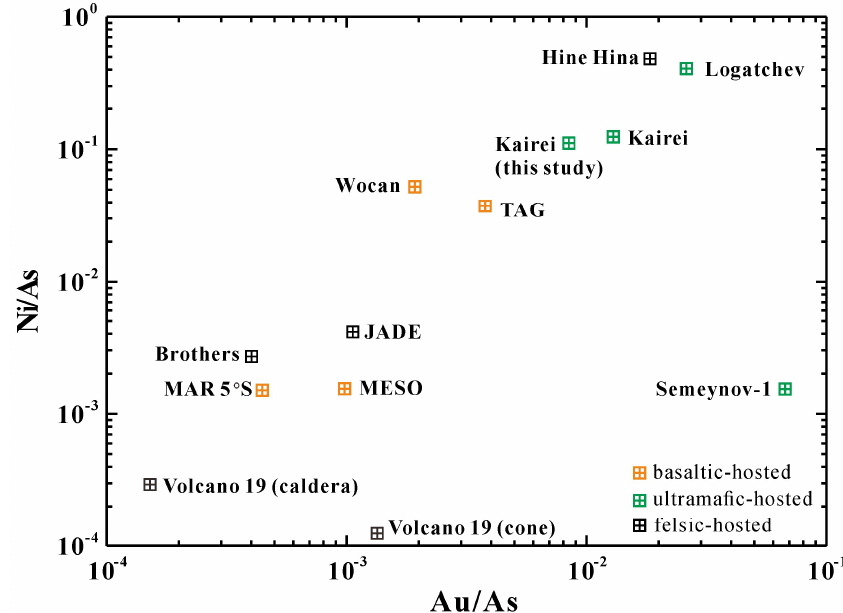
Figure 9. Variations of Ni/As vs. Au/As in pyrite from ultramafic- and mafic-hosted hydrothermal systems at mid-ocean ridges and felsic-hosted sites occurred in the back-arc basin/arc volcanoes. See the data source in Table